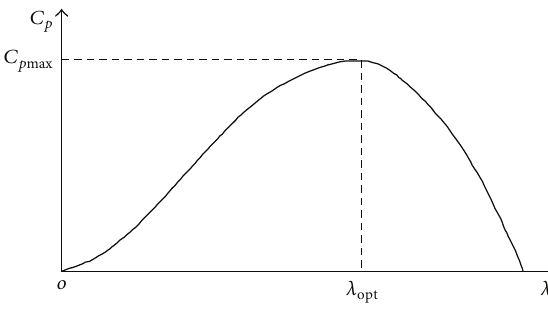
Figure 2: Blade characteristic: 𝐶 𝑝 versus 𝜆